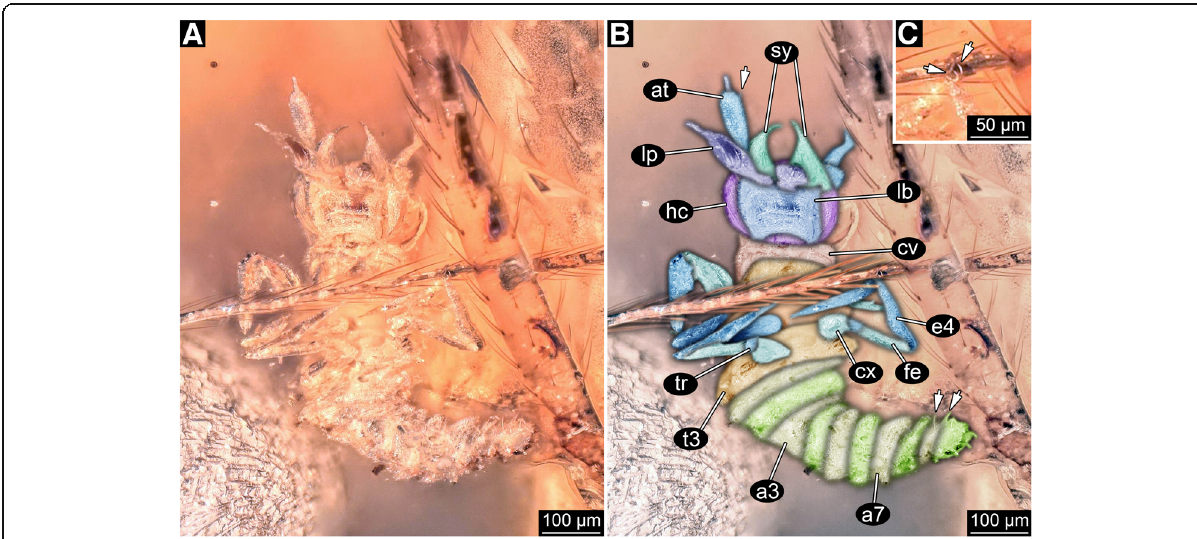
Fig. 2 Details of the mantis lacewing larva. a Close-up of larva; coaxial cross-polarised light, HDR. b Colour-marked version of A; arrows mark some of the setae. c Close-up of claws (arrows). Abbreviations: a3 = abdominal segment 3 (post-ocular segment 11); a7 = abdominal segment 7 (post-ocular segment 15); at = antenna (antennula in euarthropod terminology); cv = cervix (neck region); cx = coxa (appendage element 1); e4=appendage element 4 (tibia+tarsus?); fe=femur (appendage element 3); hc=head capsule; lb. =labium; lp =labial palp; sy=mandibular-maxillary stylet; t3=thoracic segment 3 (post-ocular segment 8); tr=trochanter (appendage element